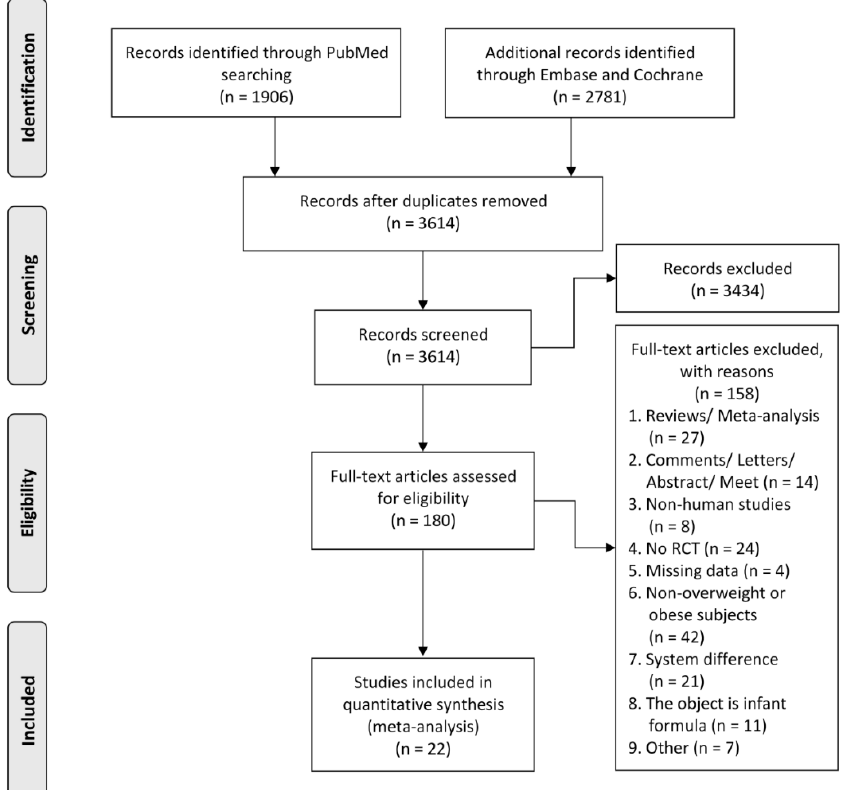
Figure 1. Flow diagram of study selection for meta-analysis.